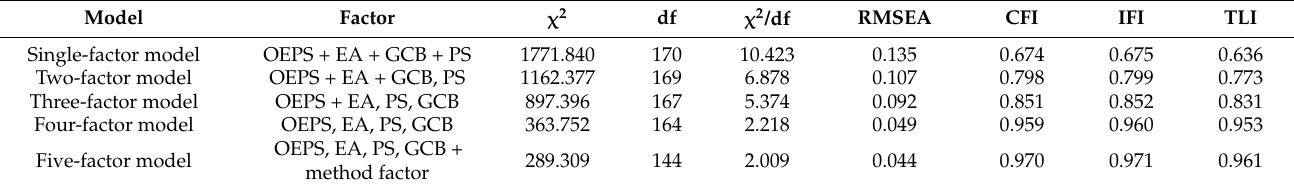
Table 5. The results of the confirmative factor analysis.